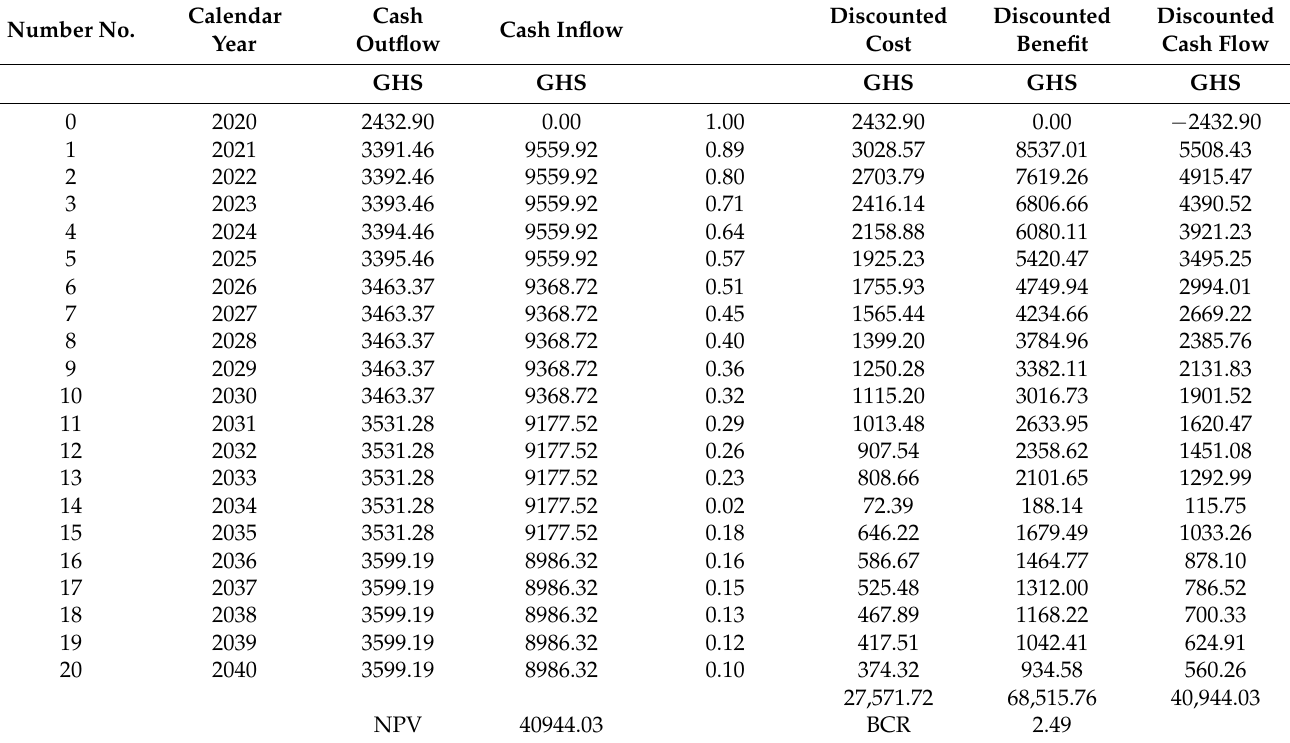
Table A5. Cash flow of farmers involved in cash